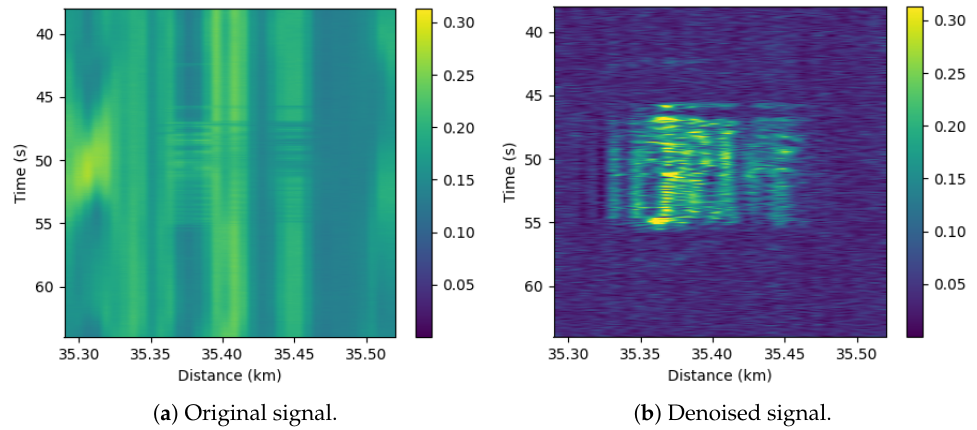
Figure 7. Comparison of the original and denoised signals around 35 km ditch for Hydraulic .